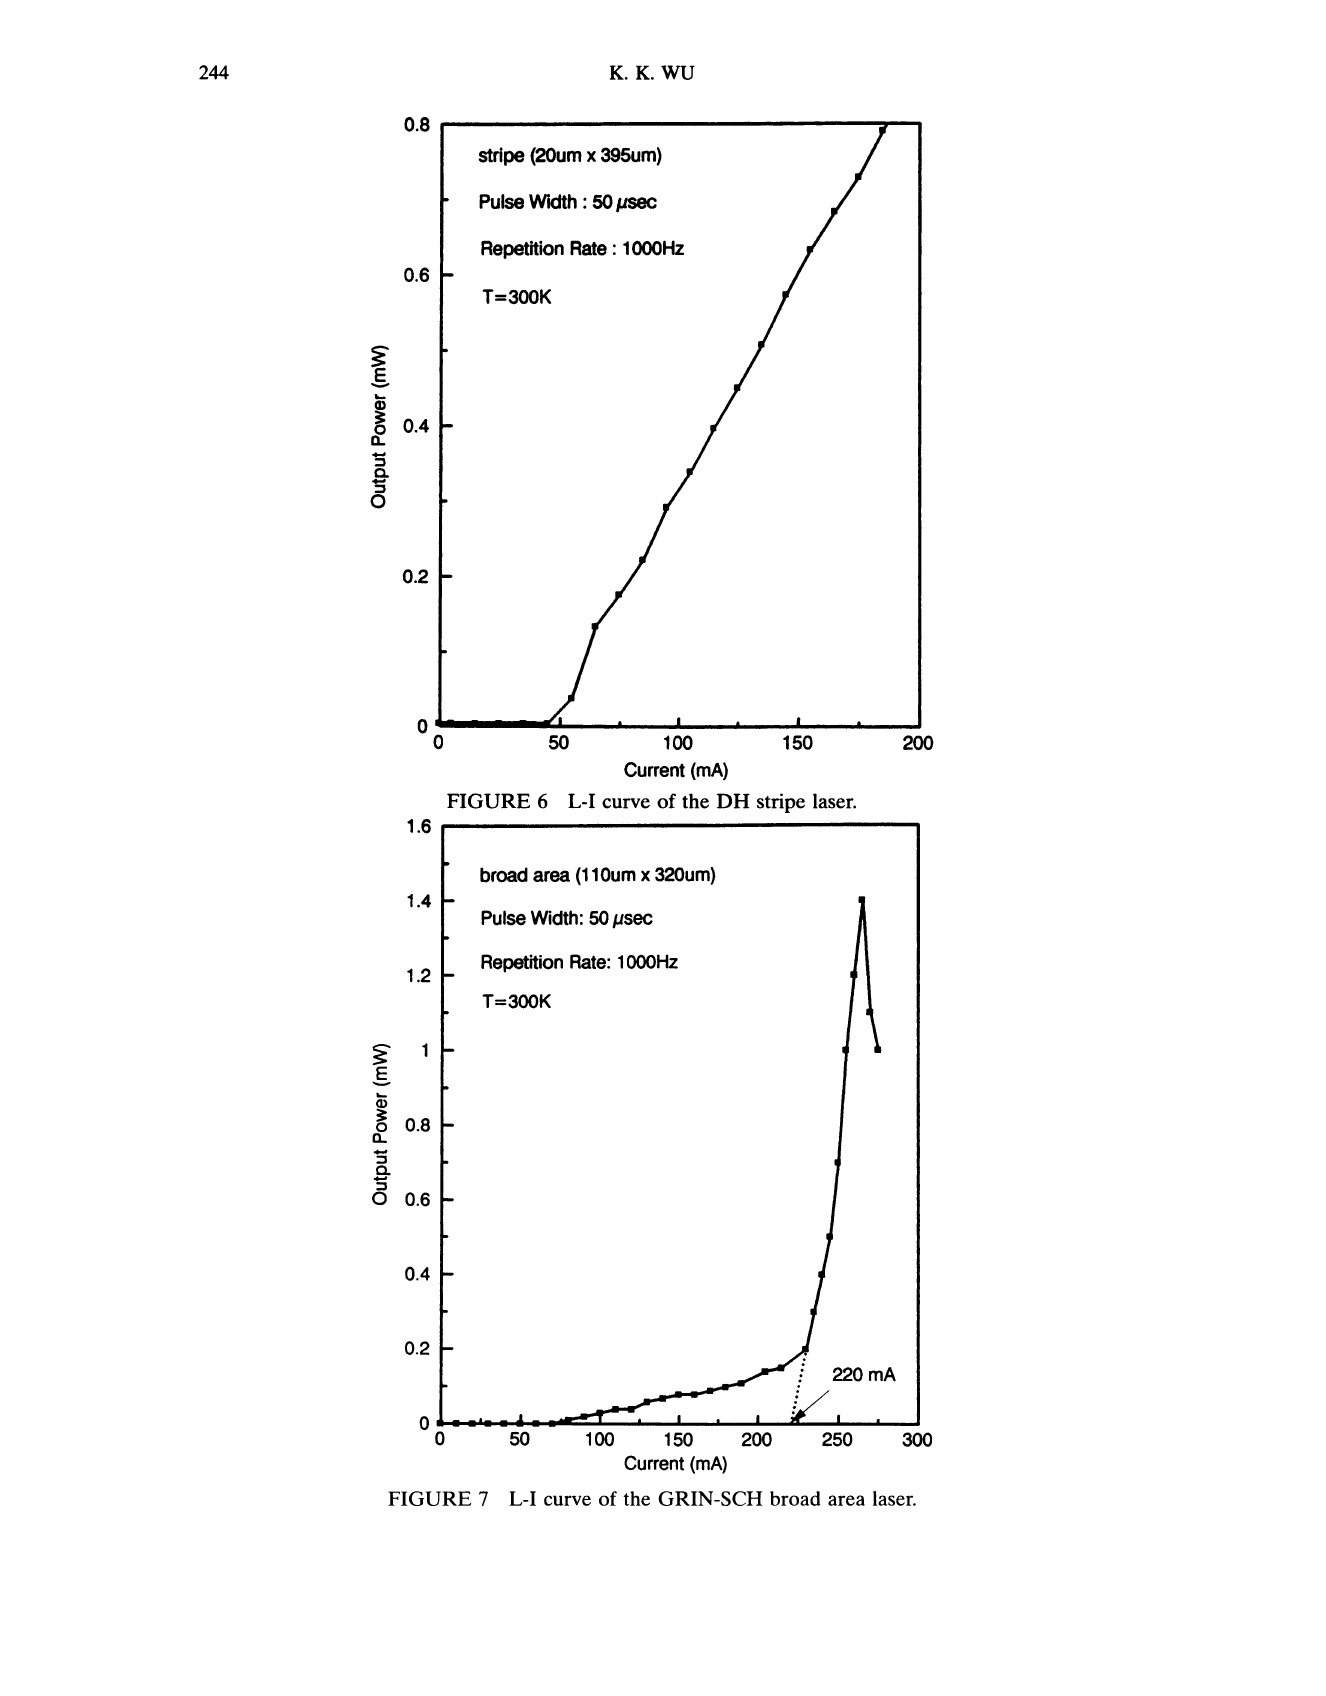
FIGURE 7 L-I curve of the GRIN-SCH broad area